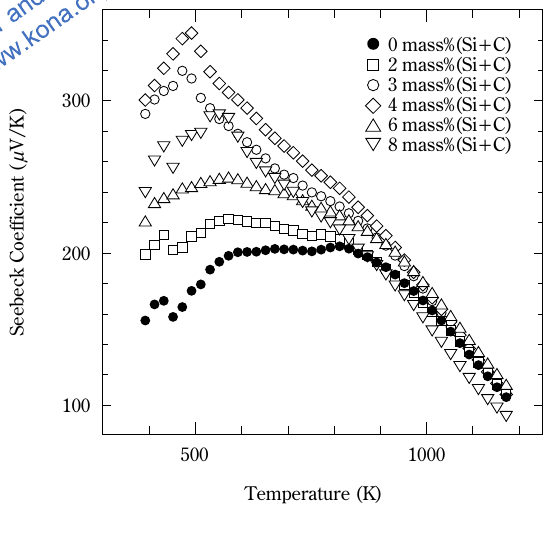
Fig. 4 Temperature dependence of the Seebeck coefficient for the sintered p-type Fe 0.92 Mn 0.08 Si 2 with addition of x mass% (Si (cid:4) C).